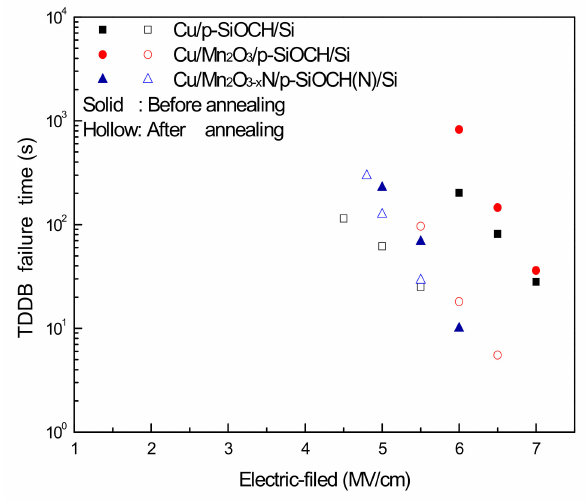
Figure 7. The time-to-fails (TTFs) of p-SiOCH film in various Cu-gate MIS capacitors as a function of the applied electric-field before and after